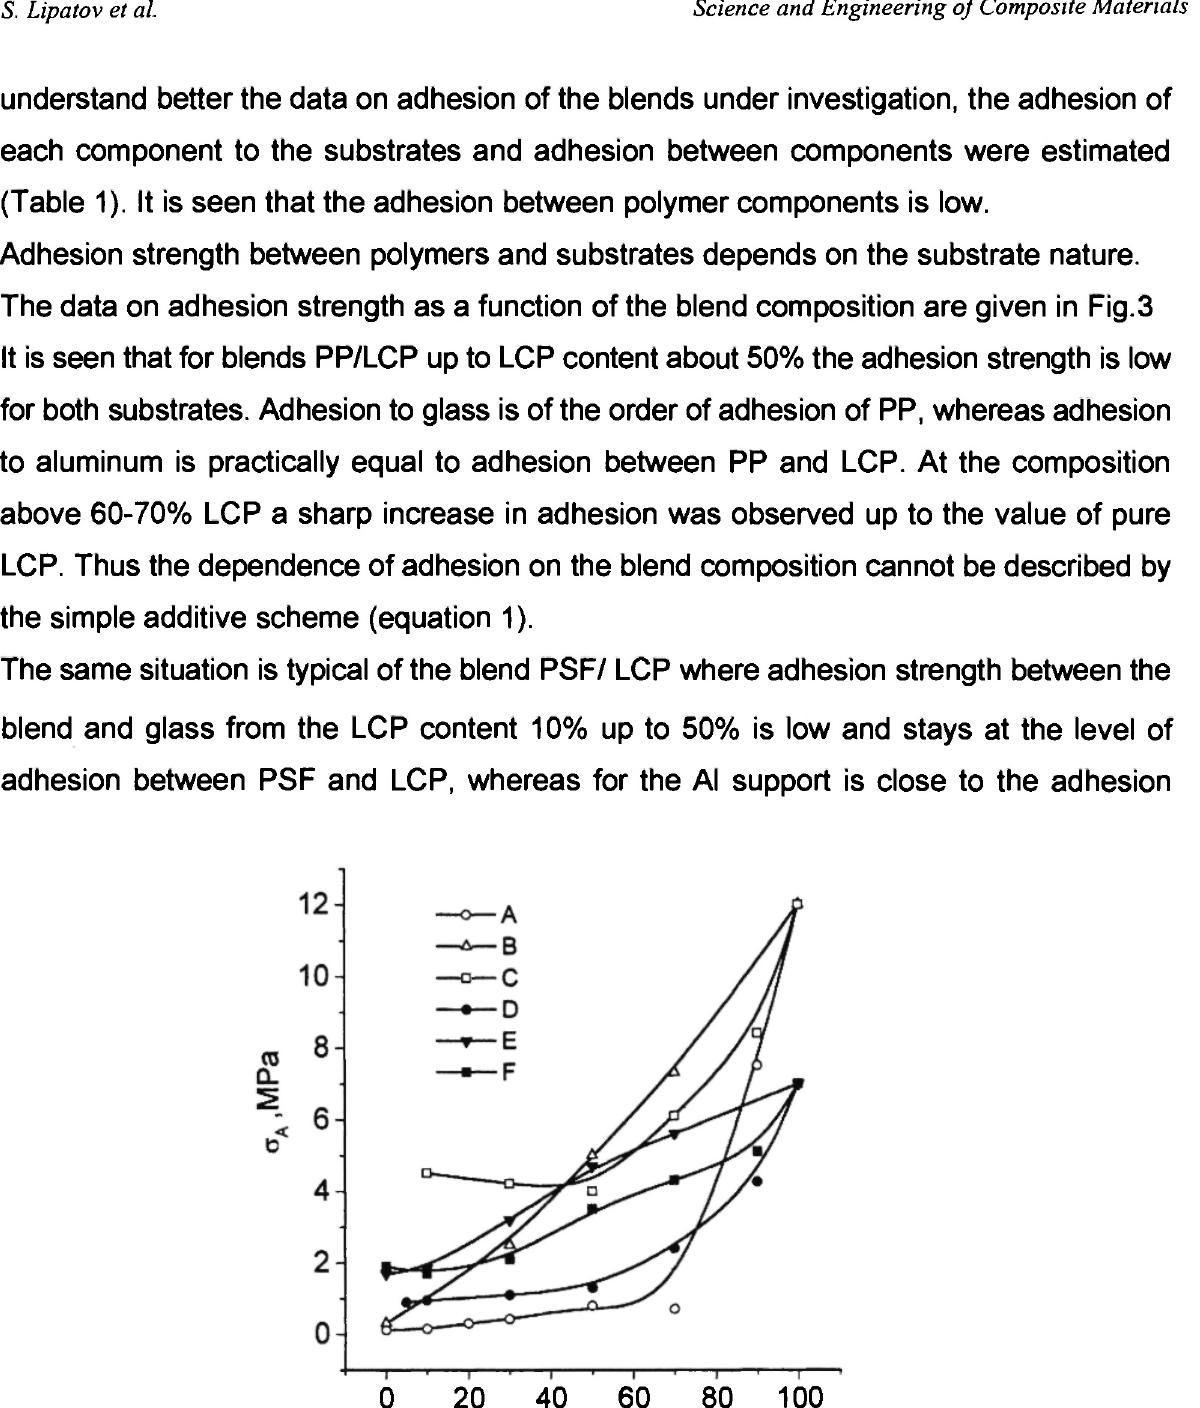
Fig.3. Dependence of σ on the blend compositions: PP/LCP (A,D), PMMA/LCP (B,E) and Α PSF/LCP